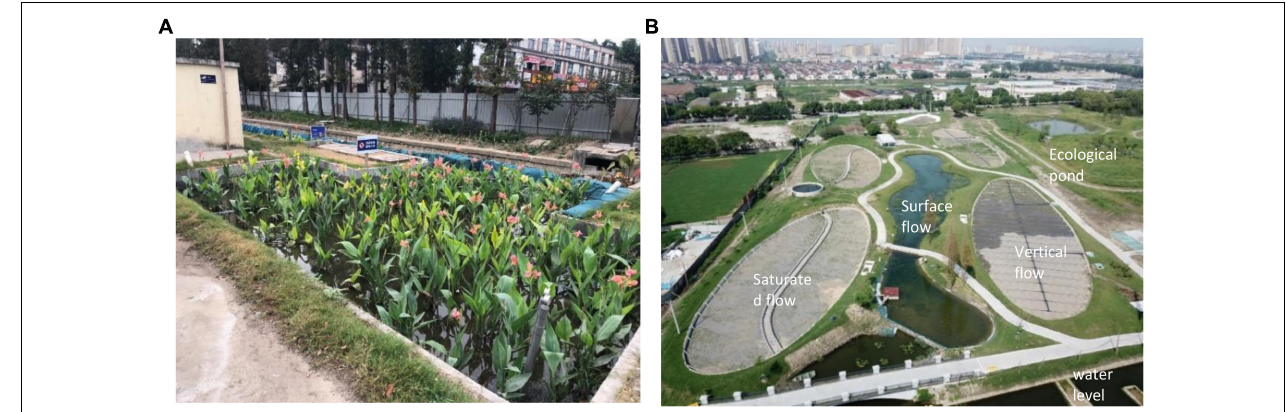
FIGURE 6 | (A) Functional plants in the constructed wetland system (Source: provided by Suzhou Dehua Ecotech company). (B) Aerial photo of the constructed wetland after built in 2018 (Source: provided by Suzhou Dehua Ecotech company).